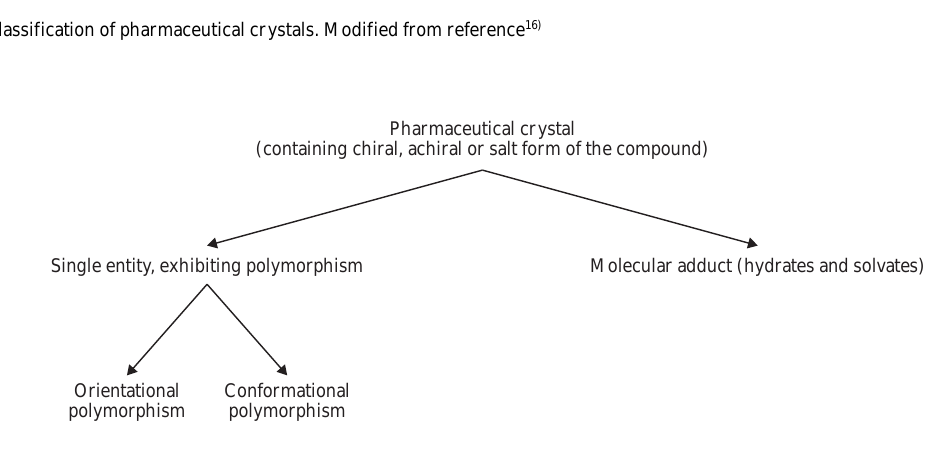
Table 1 Classification of pharmaceutical crystals. Modified from reference